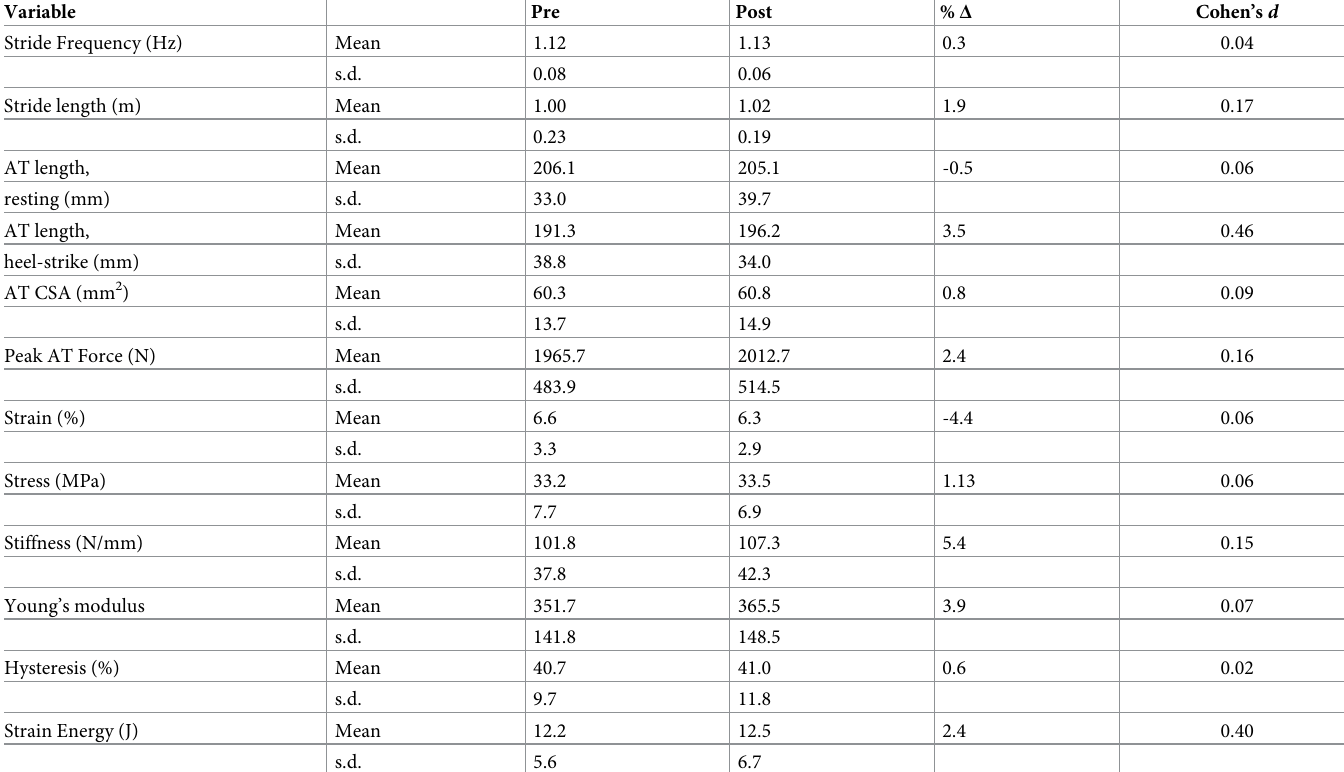
Table 1. Temporal, dimensional and functional dependant variables calculated pre- and post-training intervention. Variable